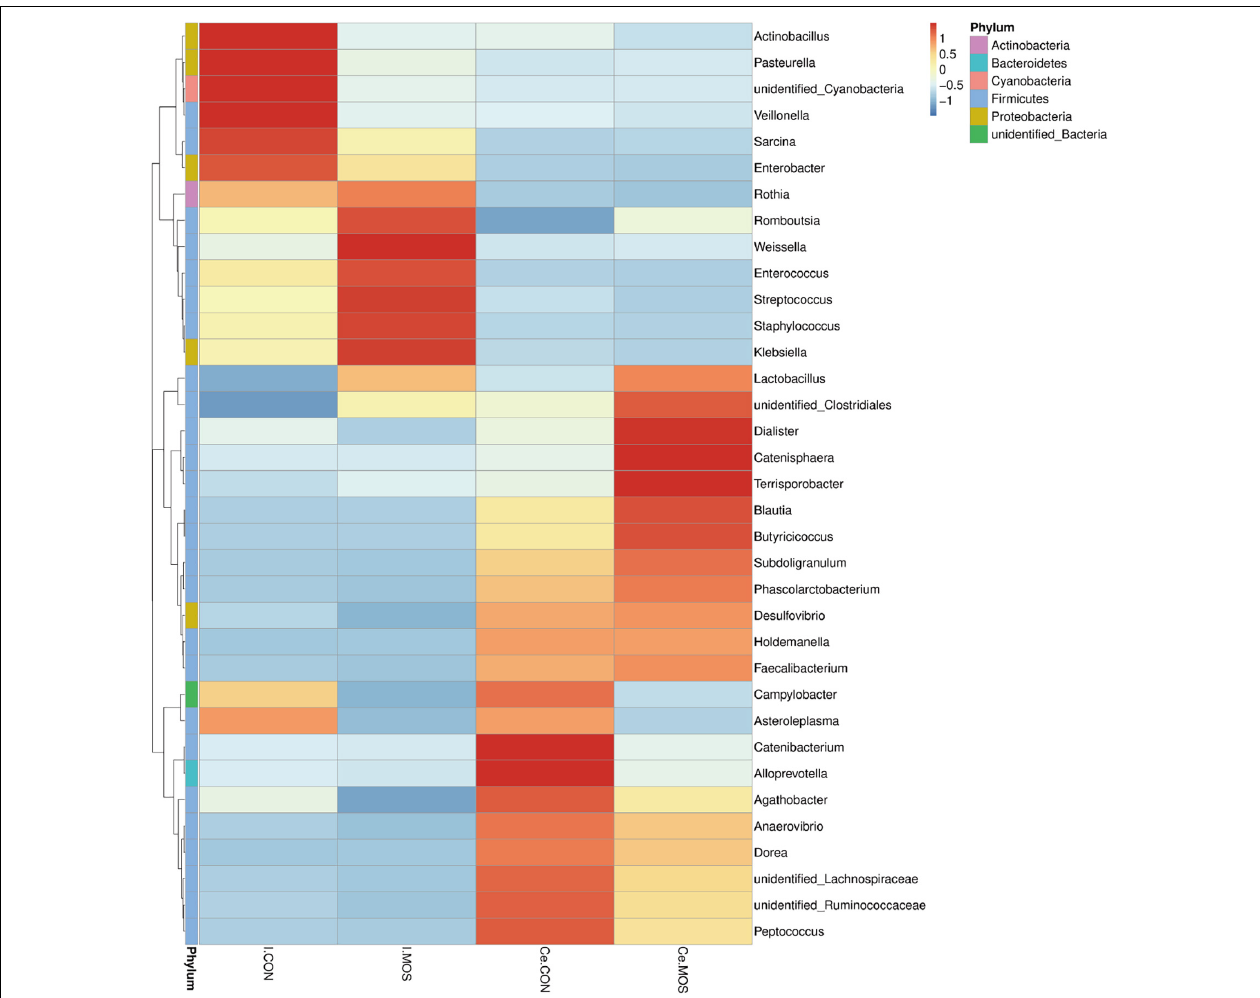
FIGURE 8 | Heatmap distribution of OTUs at phylum level. OTUs were arranged in rows and are clustered on the vertical axis. Samples are arranged vertically and are on the horizontal axis. Different colors indicate the relative abundance of taxons. I.MOS means ileal digesta samples from pigs fed with a basal diet supplemented with 3 g/kg MOS; Ce.CON means cecal digesta samples from pigs fed with the basal diet; Ce.MOS means cecal digesta samples from pigs fed with a basal diet supplemented with 3 g/kg MOS. For 16S rRNA analysis, two digesta samples in each group were pooled ( n = 4).